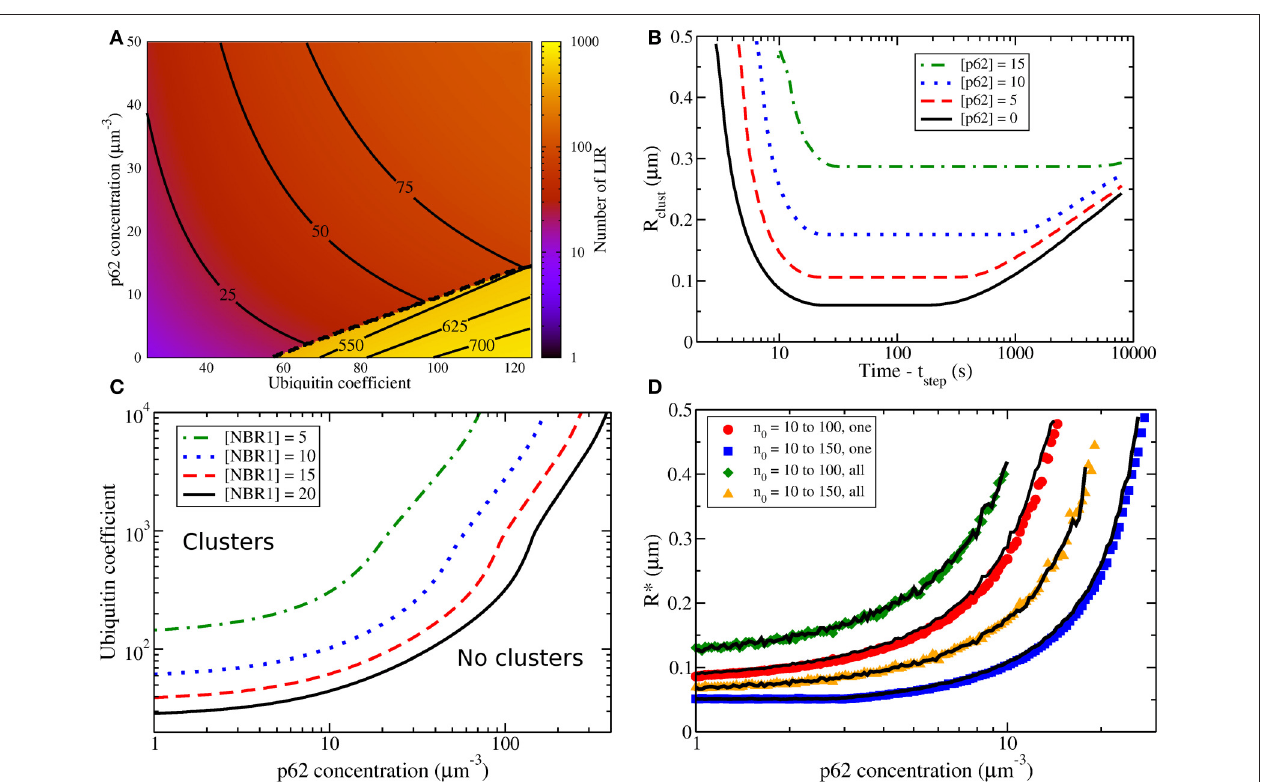
FIGURE 4 | (A) The steady-state number of LIR domains on a single peroxisome after equilibration, given by the sum of the number of NBR1 and p62, as cellular [p62] (in µ m − 3 ) and number of ubiquitin are varied. R 0.25 µ m, [NBR1] 10 µ m − 3 , and V 100 µ m 3 . NBR1 clusters are present below the dashed line. = = = Increasing ubiquitin increases the LIR count, and so does increasing [p62] when no clusters are present. However, increasing [p62] suppresses cluster formation and decreases the LIR count within the clustering regime. (B) The radius of the smallest peroxisome with a cluster, R clust , vs. time, following induction of cluster formation t step . [p62] is varied as indicated, and we otherwise use the same conditions as in Figure 2C . Initially the largest after increase of the ubiquitin coefficient at t = peroxisomes form clusters, then for a decade of time no more clusters are formed, followed by cluster evaporation from the smallest occupied peroxisomes. Increasing [p62] leads to more selective cluster formation, with only the larger peroxisomes occupied by clusters. (C) Lines indicate the boundary between regimes with at least one NBR1 cluster on some peroxisome (above) and those with no clustering on any peroxisome (below), as both cellular [p62] and ubiquitin are varied as indicated. Different lines correspond to cellular [NBR1] as indicated by the legend. Other conditions are the same as in Figure 2C . For higher ubiquitin, lower [p62], or higher [NBR1] we observe clusters. Even for higher [p62], sufficiently high ubiquitin will still lead to NBR1 clusters—though note the logarithmic scale. (D) After the ubiquitin coefficient n 0 is suddenly raised (as indicated by the legend), the data shows the radius of the smallest peroxisome with a cluster at any time, R * , vs. cellular p62 concentration. The disuse and damage scenarios correspond to ubiquitin being increased on all peroxisomes (“all,” diamonds and triangles) or increased only on a single peroxisomes (“one," circles and squares), respectively. The damage scenario leads to significantly smaller R * , as does a larger final ubiquitin coefficient. While the data points represent an initial ubiquitin coefficient of n 0 10, the black lines represent initial ubiquitin coefficient of n 0 25, and their agreement indicates that = = n 0 ( R / R 0 ) 2 , with R 0 the initial ubiquitin coefficient is not significant. The number of ubiquitin on a peroxisome is N Ub 0.25 µ = =